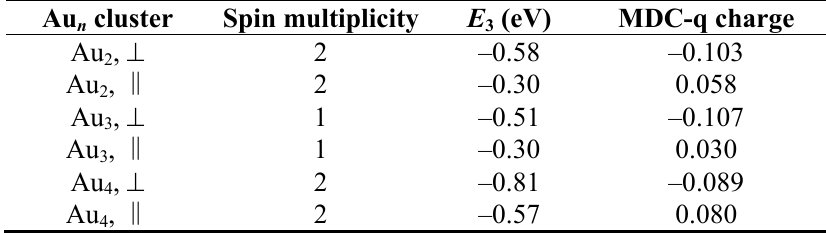
( n = 2–7) clusters on n